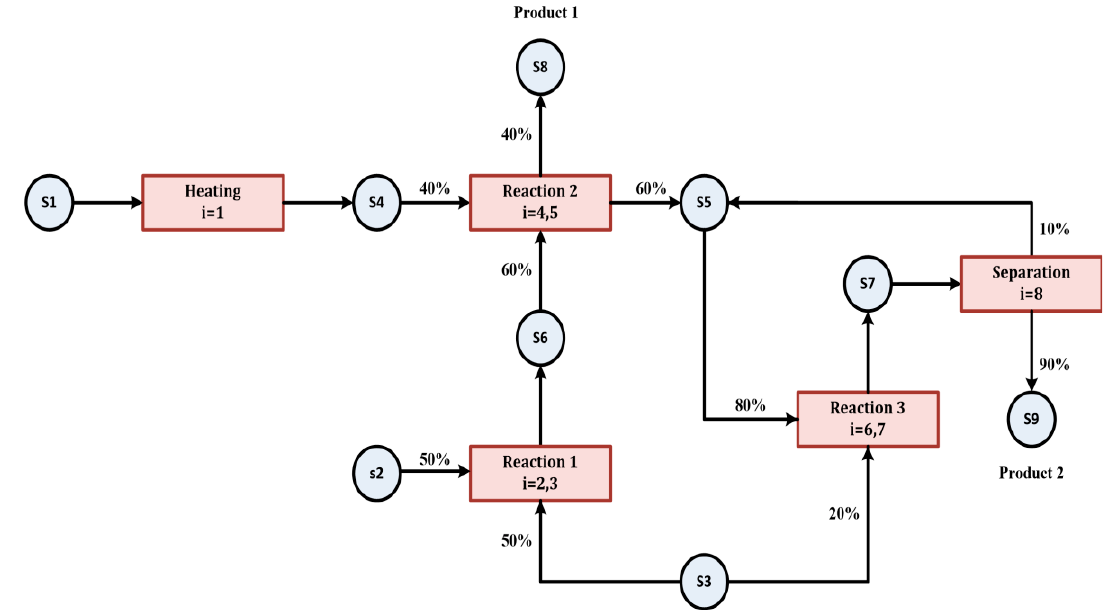
Figure 4. STN representation for case study 1.